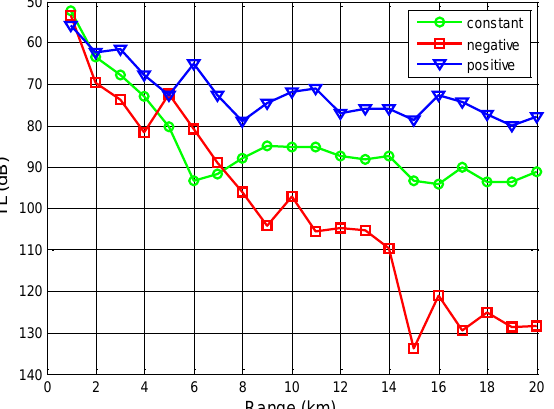
Figure 12. Transmission loss vs. horizontal range, under different sound speed